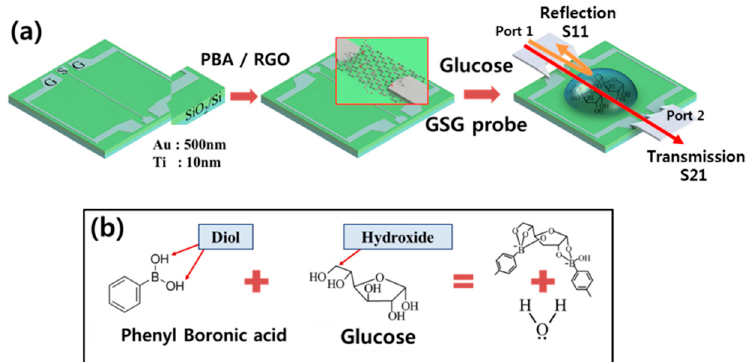
Figure 1. ( a ) Schematic of radio frequency (RF) measurement system with transmission and reflection between signal electrodes on ground-signal-ground (GSG) pattern ( b ) chemical reaction between phenylbutyric acid (PBA) and glucose.